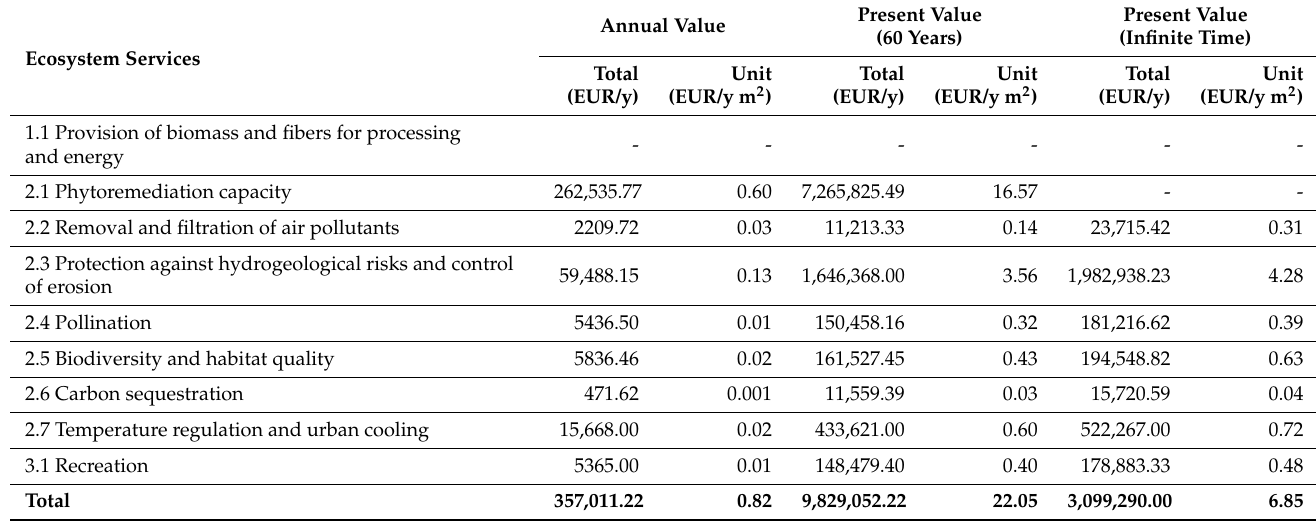
Table 13. Summary of ES values for scenario 2—meadows with sparse